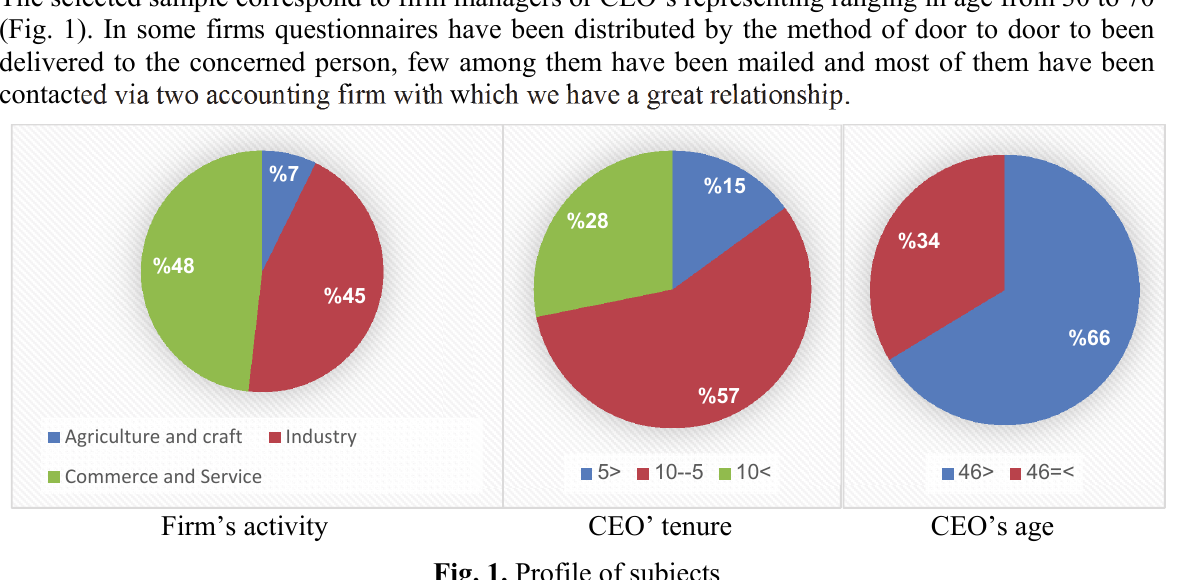
Fig. 1. Profile of